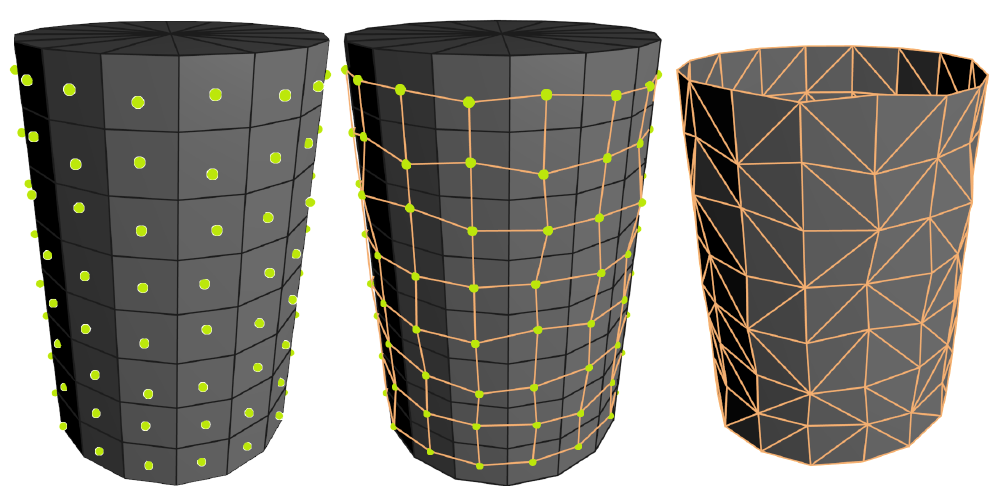
Figure 2. Stages of triangulation. ( Left ) Each vertex (green) is computed as the mean of points in each cell; ( centre ) neighbouring cells are connected by edges; ( right ) The quads are further triangulated, forming the